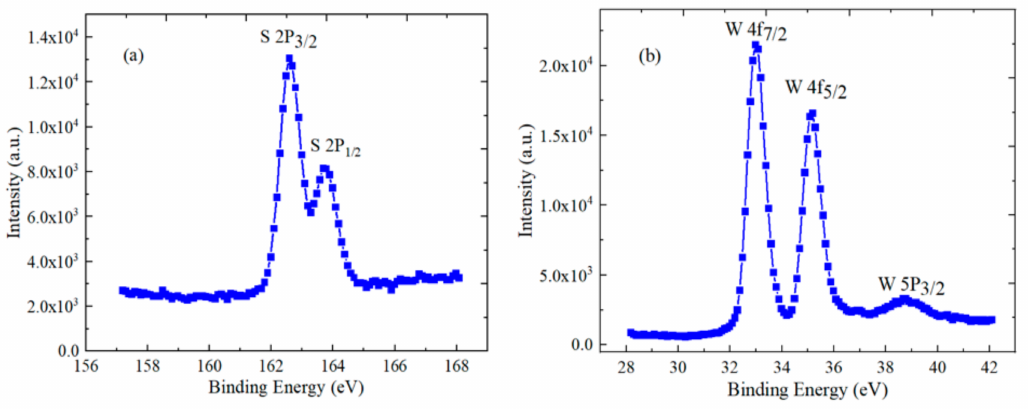
Figure 1. XPS spectra of WS 2 material ( a ) S element, ( b ) W